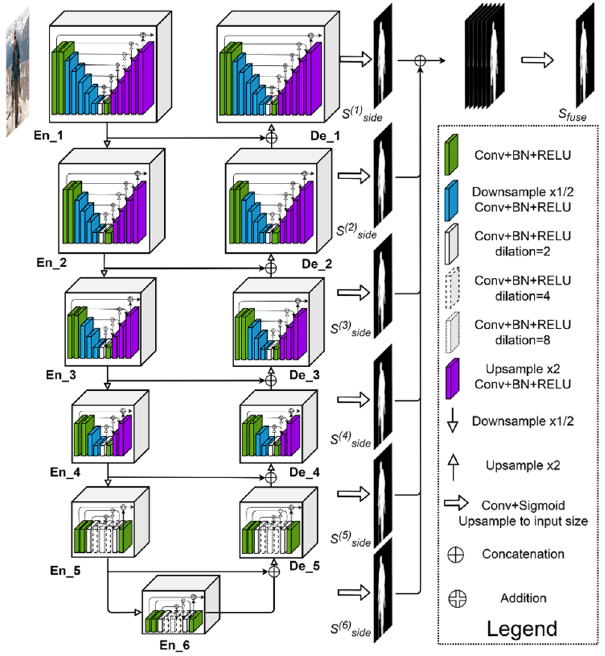
Figure 9. The network architecture of U2-Net model [37].